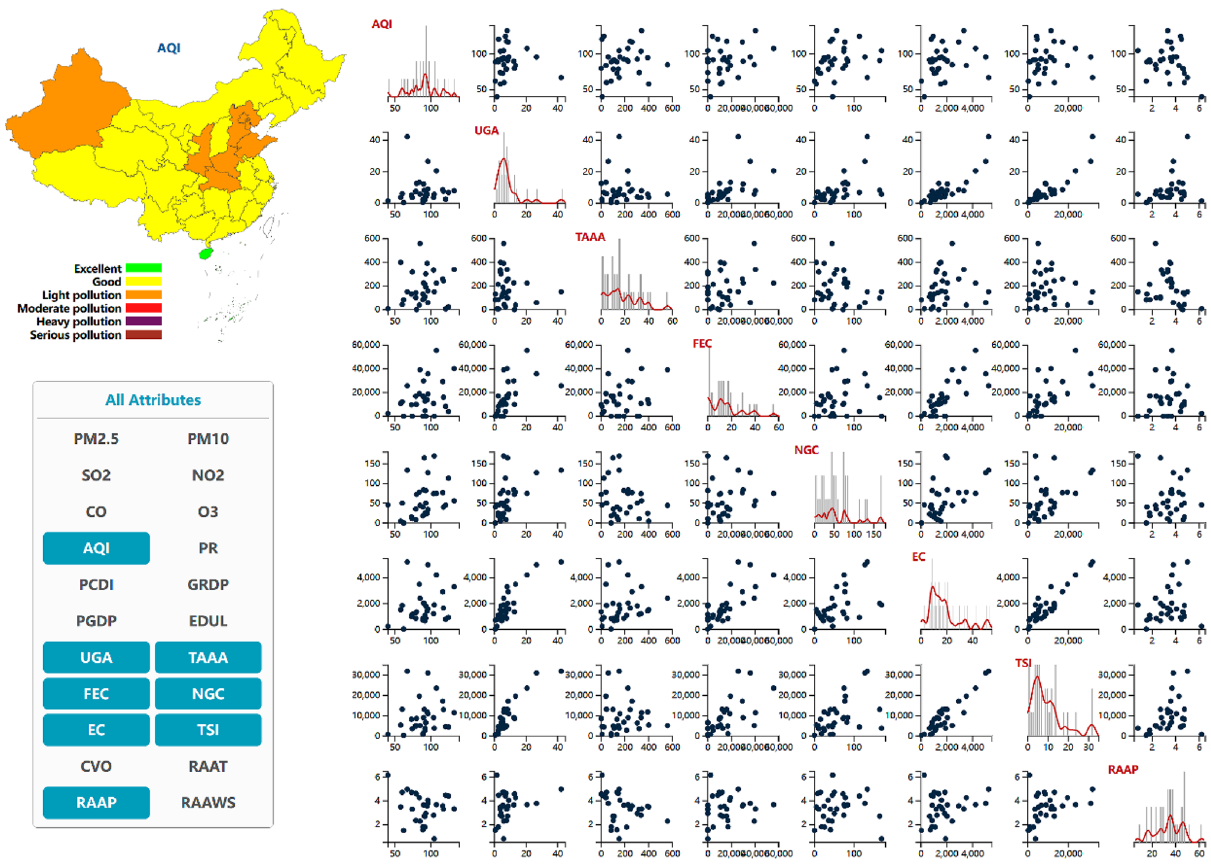
Figure 5. Scatterplot matrices of the customized